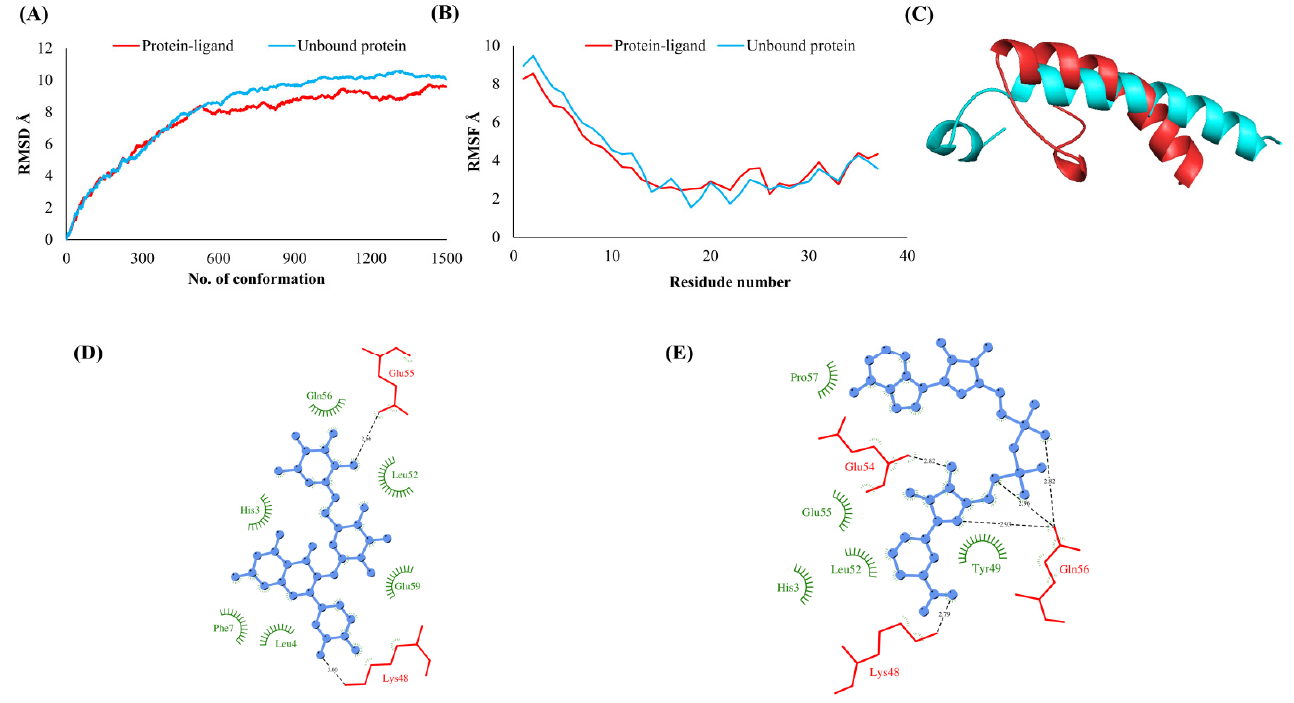
Figure 12. ORF6. ( A ) RMSD plot of unbound and ligand-bound protein ( B ) RMSF plot of unbound and ligand-bound protein ( C ) Superimposition of unbound and ligand-bound protein ( D ) Molecular interactions of protein with Rutin ( E ) Molecular interactions of protein with NADH.